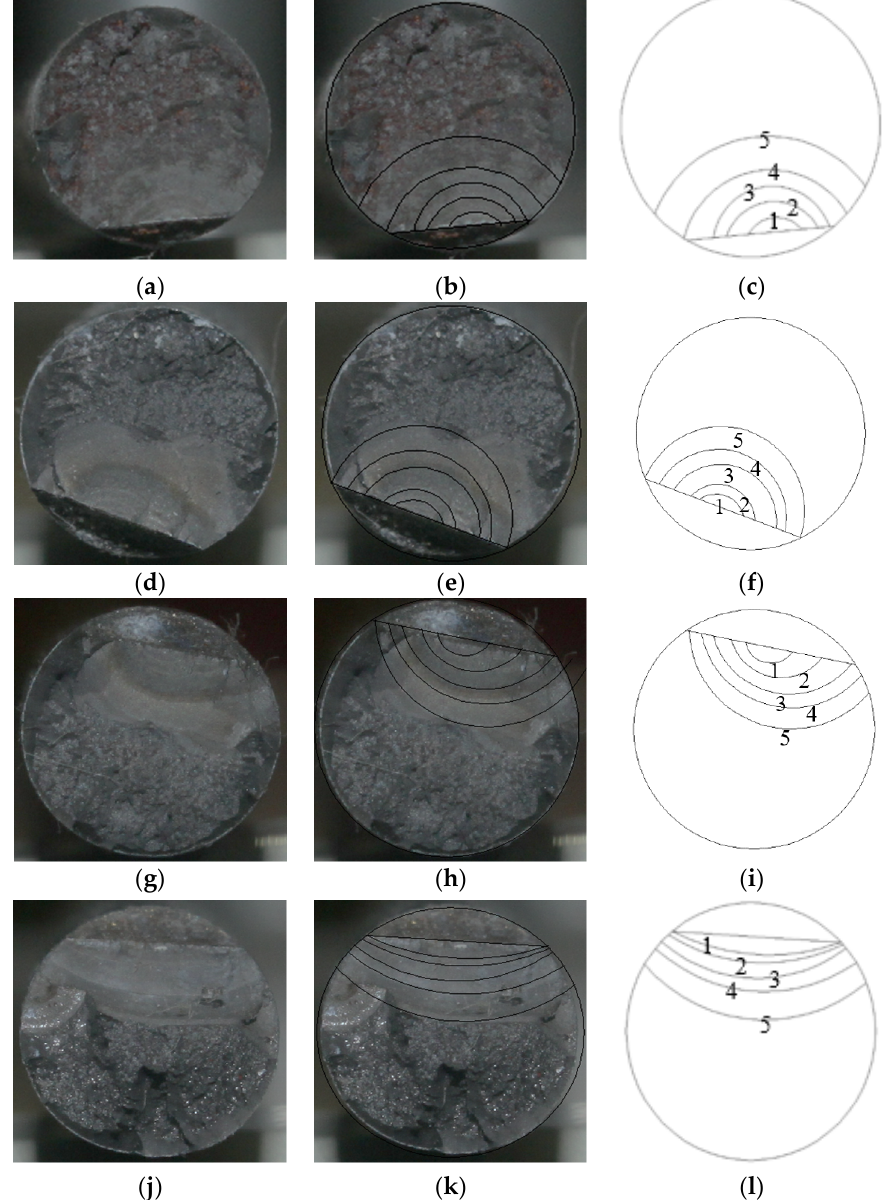
Figure 21. Steel wire sections with notches at different widths. ( a ) L-1 without “bench-like pattern”; ( b ) L-1 with “bench-like pattern”; ( c ) schematic diagram of L-1 wire specimen; ( d ) L-2 without “bench-like pattern”; ( e ) L-2 with“bench-like pattern”; ( f ) schematic diagram of L-2 wire specimen; ( g ) L-3 without “bench-like pattern”; ( h ) L-3 with “bench-like pattern”; ( i ) schematic diagram of L-3 wire specimen; ( j ) L-4 without “bench-like pattern”; ( k ) L-4 with “bench-like pattern”; and ( l ) schematic diagram of L-4 wire specimen.